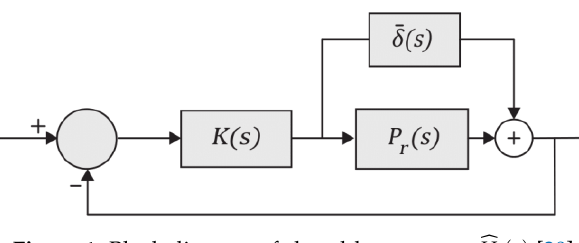
Figure 1. Block diagram of closed-loop system 𝐻̂ 𝑙 (𝑠) [20].